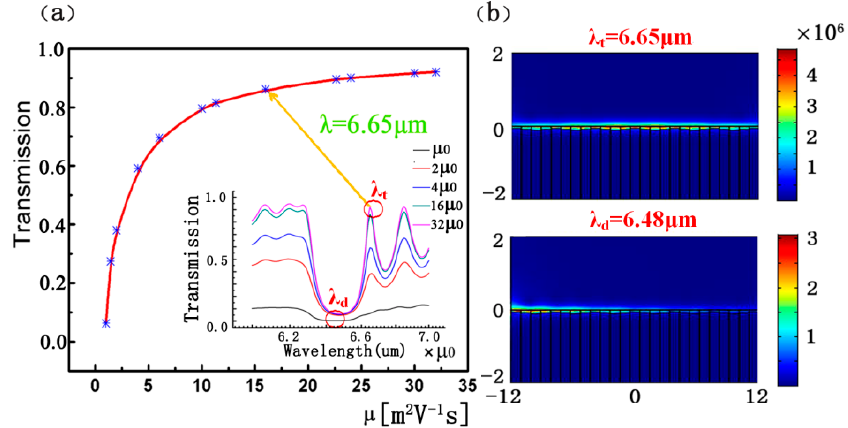
Figure 6. ( a ) The transmission at λ t = 6.65 μ m as a function of carrier mobility for the three-step structure considering the material losses of graphene. The inset is the transmission spectrum for a different carrier mobility μ . Here, μ 0 is set as 1 m 2 ·V − 1 ·s − 1 , and the bias voltages are V bias = 3.2 V. ( b ) The 2D distributions of the electric field | E | 2 at excitation wavelengths λ t and λ r when V bias = 3.2 V.